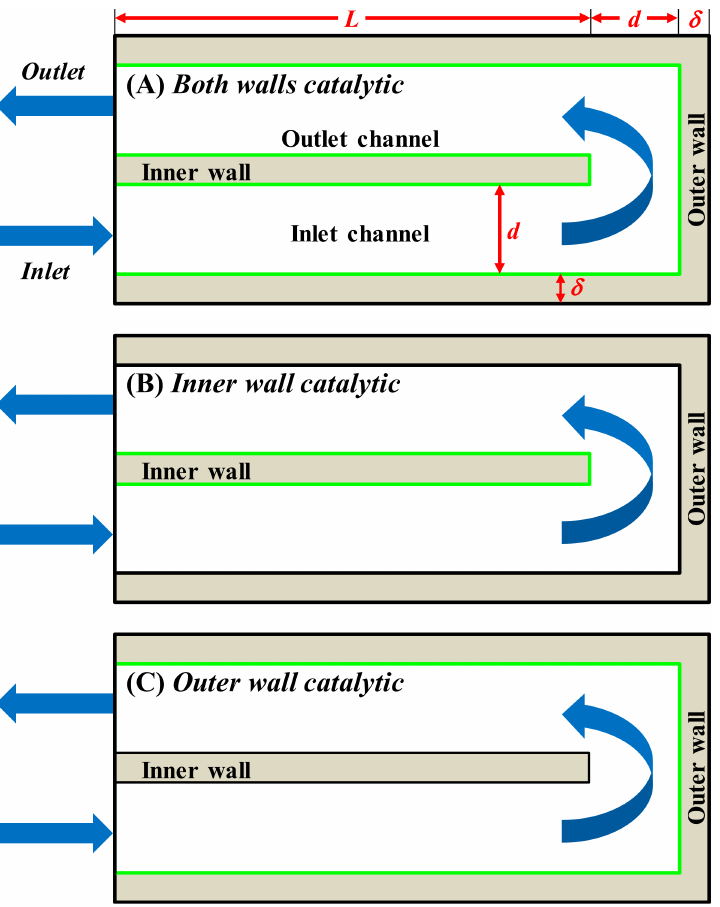
Figure 1. Two-dimensional computational domain (not to scale) of the U-bend heat-recirculating micro-combustor, with length L = 12.5 mm, channel gap size d = 0.6 mm, and wall thickness δ = 0.2 mm. The green lines denote the catalytic surfaces where heterogeneous combustion oc- curs. Three different configurations are compared in this work: ( A ) Both walls catalytic ; ( B ) Inner wall catalytic ; and ( C ) Outer wall catalytic . Heterogeneous combustion occurs only on the catalytic walls, whereas homogeneous combustion occurs in the entire fluid